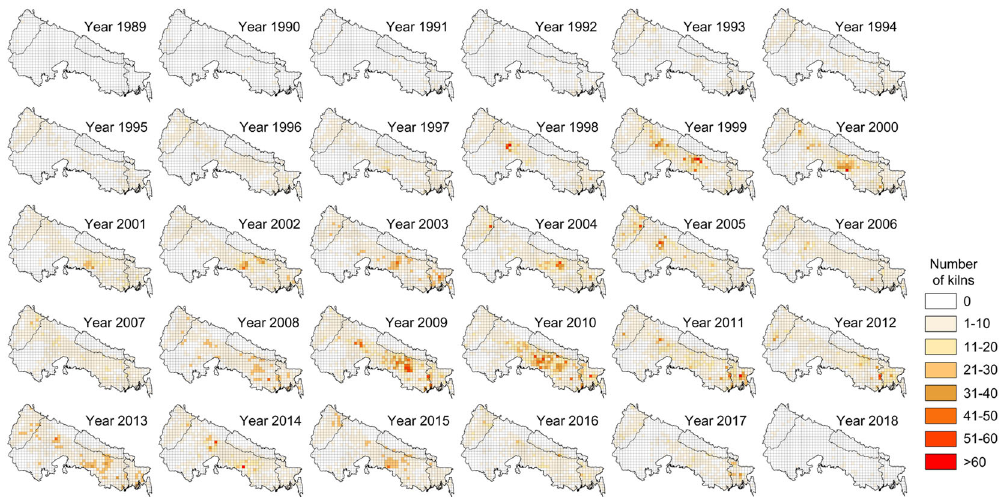
Fig. 4 Mapping of the density of Bull ’ s Trench brick kilns (number of kilns per 50 × 50 km 2 ) constructed annually. Each map illustrates the number of brick kilns established in a year (from 1989 through to 2018, with the number of kilns in each 50 x 50 km 2 area depicted by the key. HUMANITIES AND SOCIAL SCIENCES COMMUNICATIONS| (2021) 8:111